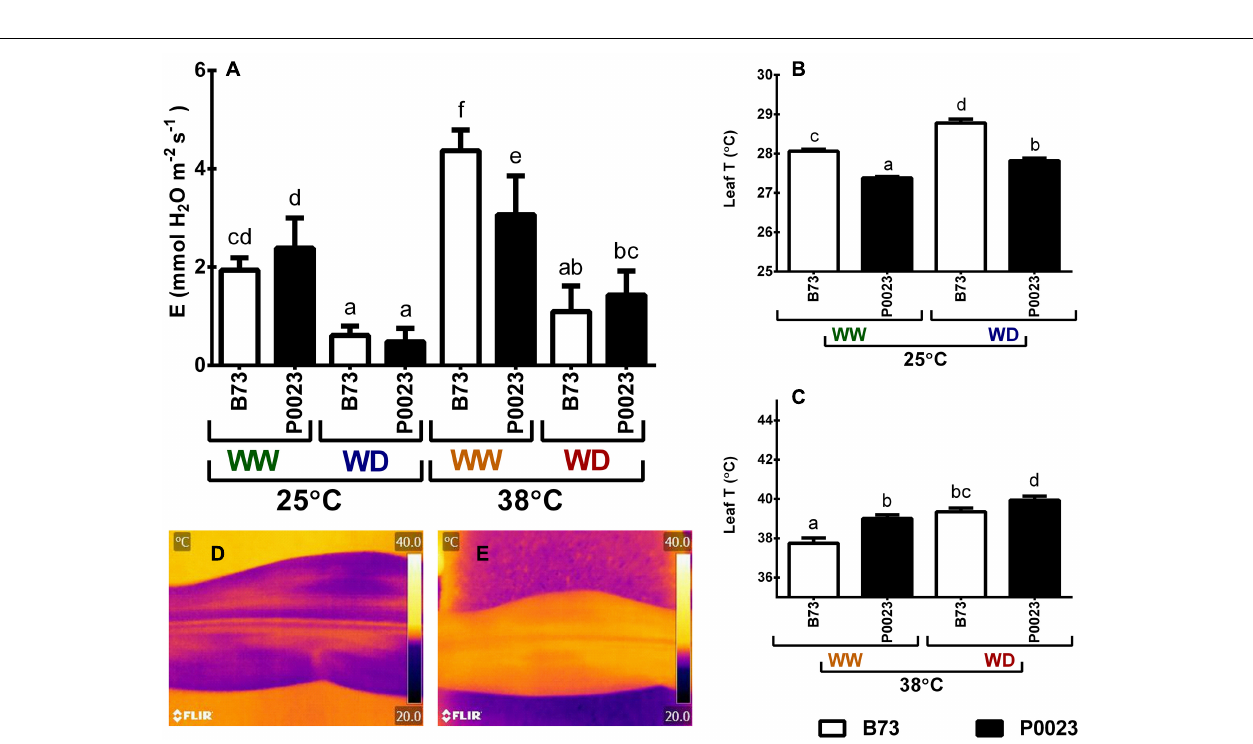
FIGURE 3 | The leaf evaporative cooling system of two maize genotypes (B73, P0023) grown under WW and WD conditions and acclimatized to 25 or 38 ◦ C. (A) Transpiration rate, (B) leaf temperature at 25 ◦ C and (C) leaf temperature at 38 ◦ C. (D,E) Representative thermographic images from the leaves of 4-week-old maize plants under WW (D) and WD (E) conditions, exposed to 25 ◦ C. Values are mean ± SEM ( n = 5 biological replicates). Different letters denote statistically significant differences between treatments (Duncan analysis, p < 0.05).